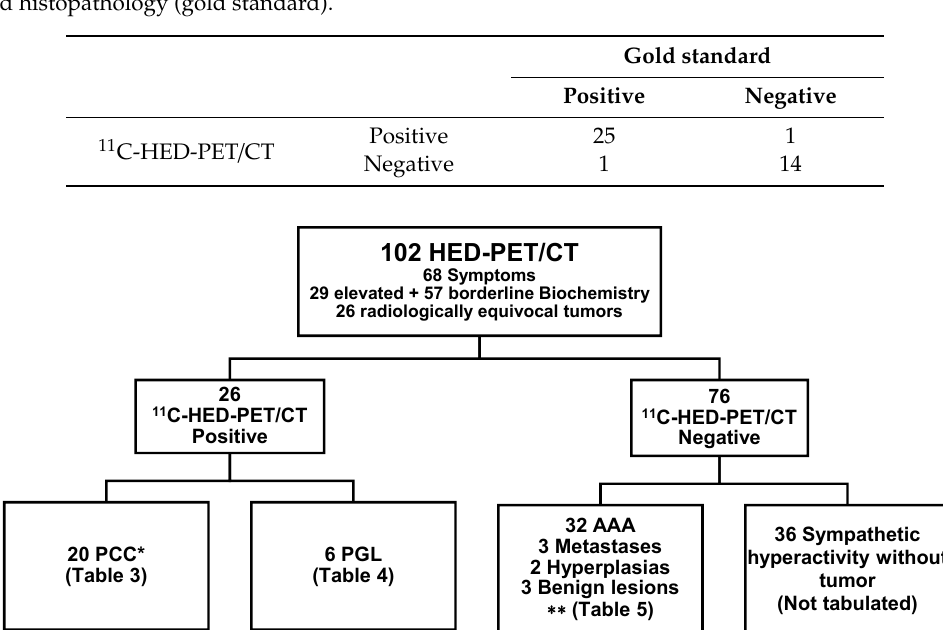
Figure 1. Flowchart of the 102 study patients. 11 C-HED-PET / CT visualized 20 PCC (Table 3) and six PGL (Table 4) and ruled out PCC / PGL in 76 patients, including 40 patients with adrenal tumors (Table S1) and 36 without tumors. * including one false negative 11 C-HED-PET / CT result, ** including one false positive PET / CT result. AAA; adrenocortical adenoma.